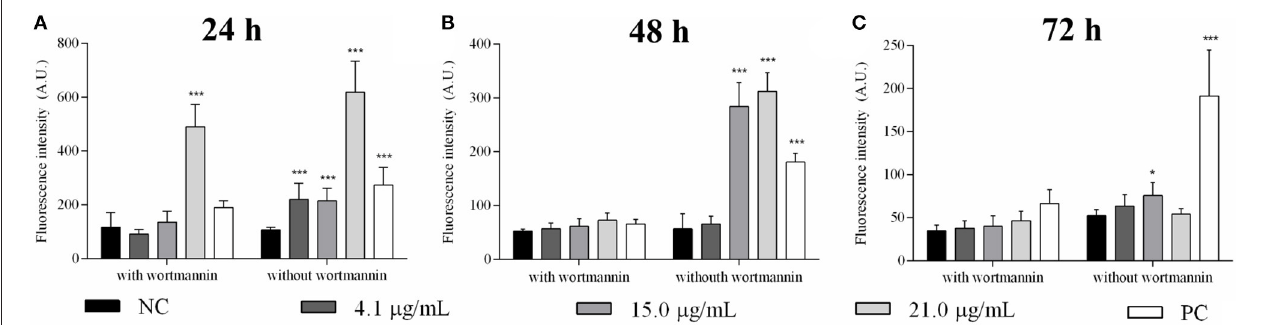
FIGURE 3 | Detection of autophagic vacuoles in L. infantum promastigotes treated with free sugiol. Bars indicate the mean ± SD of MDC fluorescence used to detect autophagic vacuoles induced by different concentrations of sugiol after (A) 24h, (B) 48h, and (C) 72h. Wortmannin, a known inhibitor of autophagic vacuole production, was used to ensure the MDC fluorescence specificity. Generation of autophagic vacuoles in promastigotes promoted by starvation was the strategy to obtain the positive control (PC). Fluorescence was measured in arbitrary units (A.U.) with Perkin Elmer Victor-X3 fluorometer. Three independent experiments were performed. * p < 0.05 and *** p < 0.001, significant difference in comparison to the negative control (NC) group.